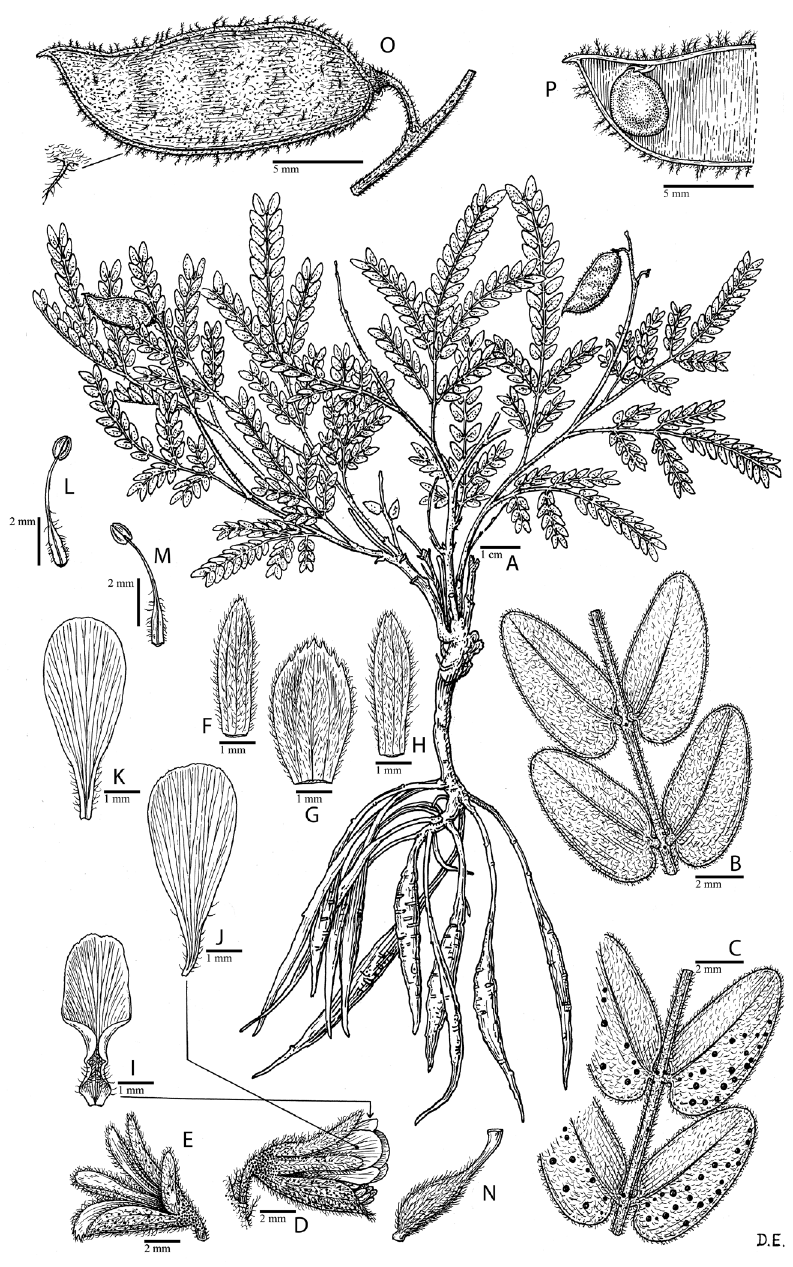
Figure 40. Pomaria burchellii (DC.) B. B. Simpson & G. P. Lewis subsp. burchellii . A habit B, C leaflets from above and beneath, respectively D flower E calyx F–H calyx lobes I median petal J upper lateral petal K lower lateral petal L, M stamens N gynoecium O fruit, with enlargement of single trichome P part of single fruit valve showing seed. A–C, O, P from Wild & Drummond 6913 D–N from Galala 72. Drawn by D. Erasmus, originally published in Flora Zambesiaca , vol. 3 part 2, page 185